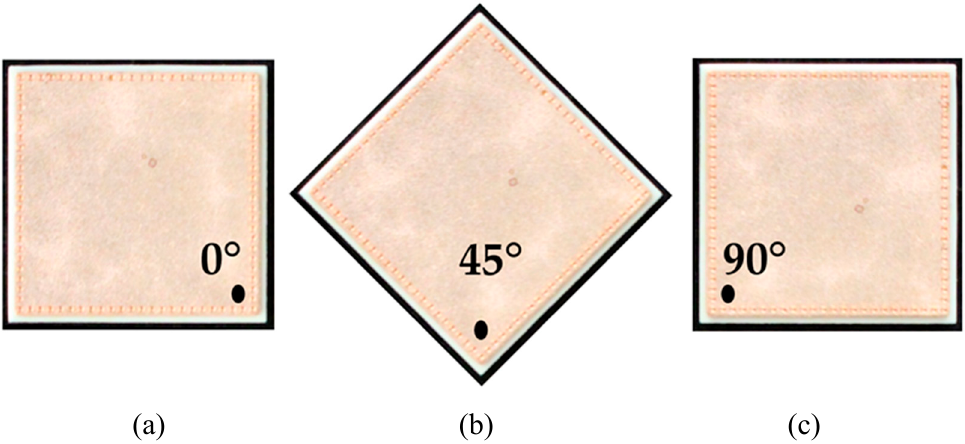
Figure 2. An example of a direct bonded copper sheet rotated according to the three different measurement angles ( a ) 0°, ( b ) 45° and ( c ) 90°.